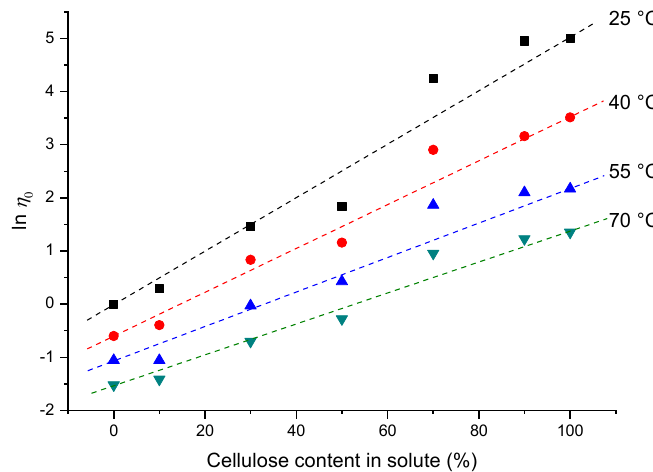
Figure 2. Zero-shear-rate viscosity versus cellulose content at different temperatures. The concentration of ZnCl 2 solution was 65 wt %, and the total content of starch/cellulose was 5 wt %. The symbols represent experimental data, and the dashed lines were calculated according to Equation (1).